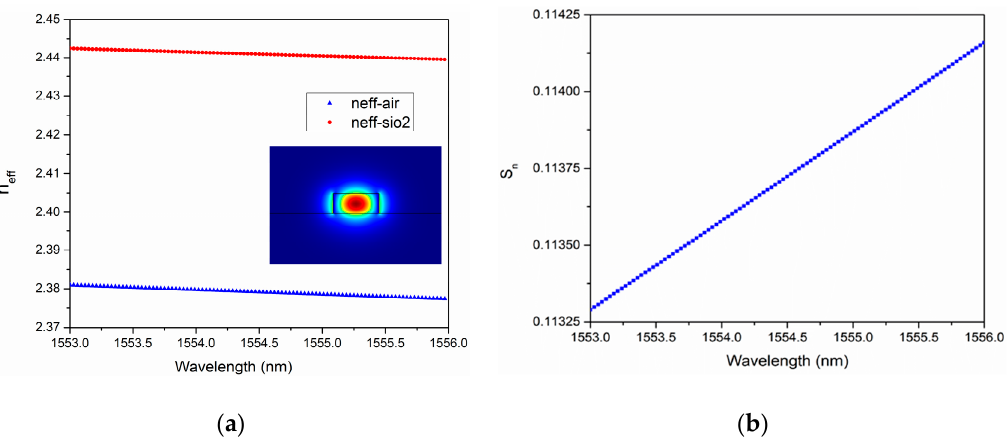
Figure 6. Waveguide dispersion of the ( a ) effective index, and ( b ) the effective sensitivity ( Sn ) for the waveguide on SOI.